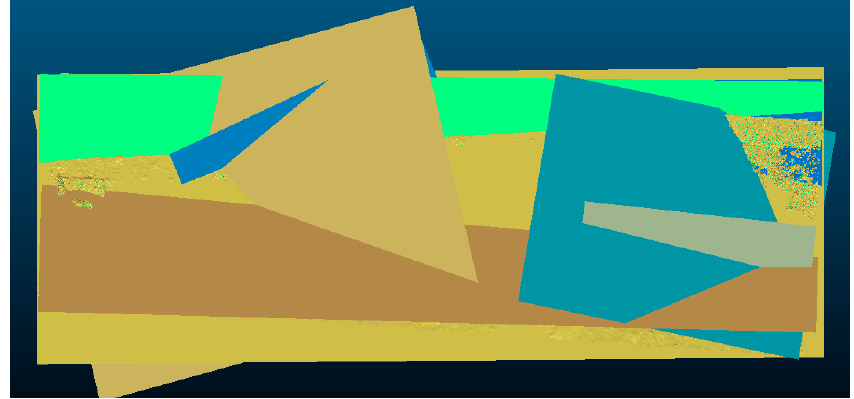
Figure 20. Application of random sampling consensus (RANSAC) algorithm with too small of a value for the number of minimum support points.